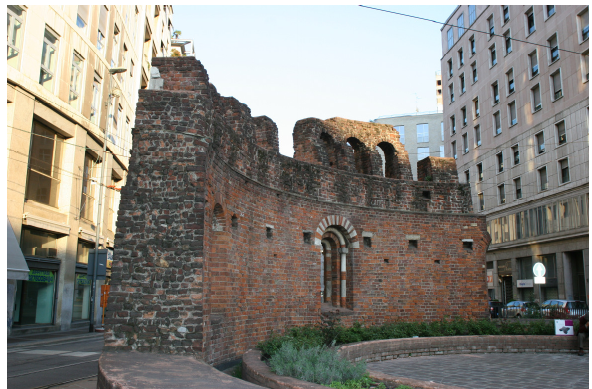
Figure 1. Ancient ruins of the Basilica in actual environment.